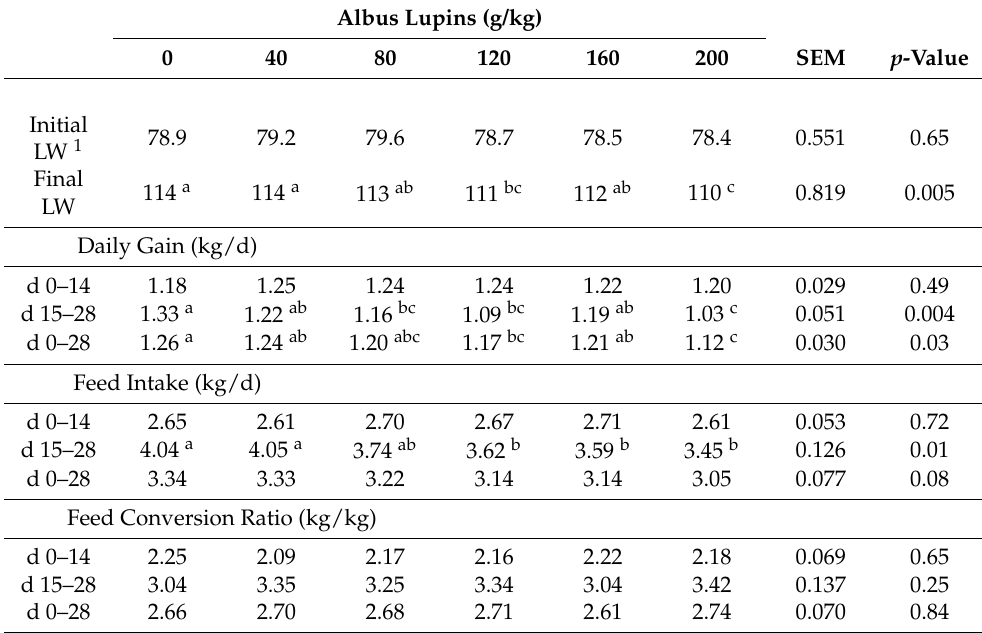
Table 3. Growth performance of pigs fed increasing concentrations of albus lupins ( n = 6/treatment).